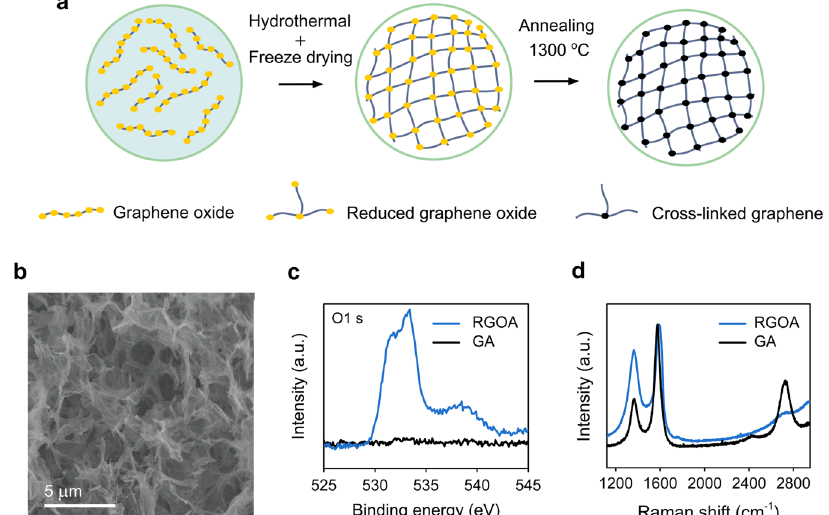
Fig. 1 Structure and chemical composition of graphene aerogels. a Schematics of the fabrication process of the cross-linked graphene aerogel. b Scanning electron micrograph of the porous structure of graphene aerogel. c X-ray photoelectron spectroscopy O 1s spectra of a reduced graphene oxide aerogel (RGOA) and the annealed graphene aerogel (GA). d Raman spectra of the graphene aerogels before and after the